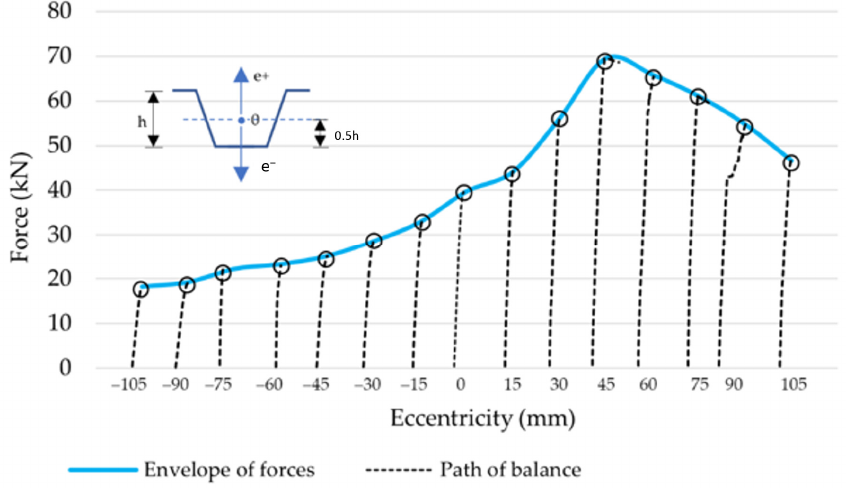
Figure 5. Results of eccentric compression tests.